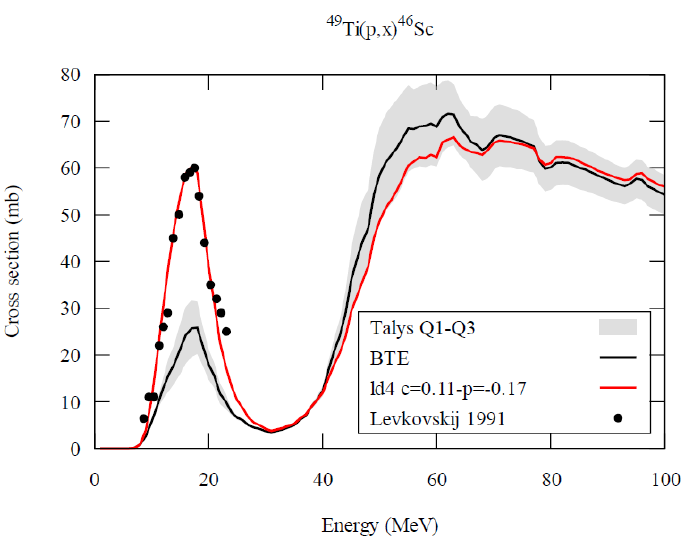
Fig. 1. Experimental and theoretical cross sections for the reaction 49 Ti(p,x) 46 Sc. The red curve corresponds to the choice of the c and p parameters given in the legend. The grey area is the interquartile band (Q3-Q1) and the black line (BTE) its most representative value.